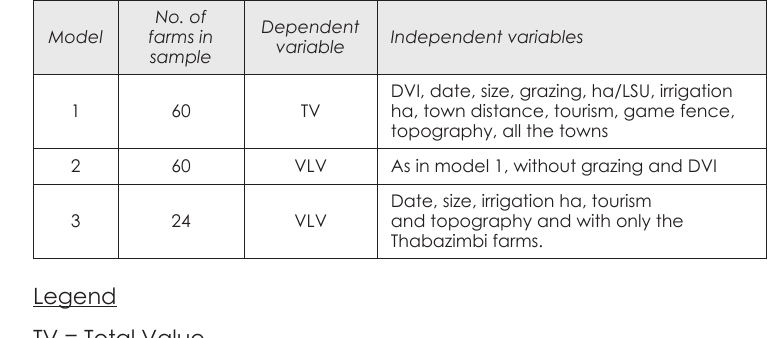
Table 10: Summary of variables used